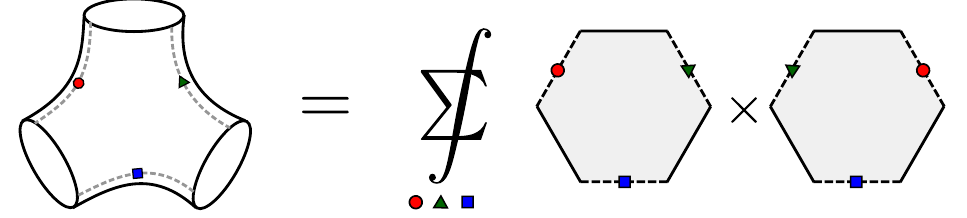
Figure 3 . The hexagon approach to the three-point function. In this approach one cuts the worldsheet into hexagonal patches and glue then together by summing over intermediate states (the states along the dashed lines in the (cid:12)gure).